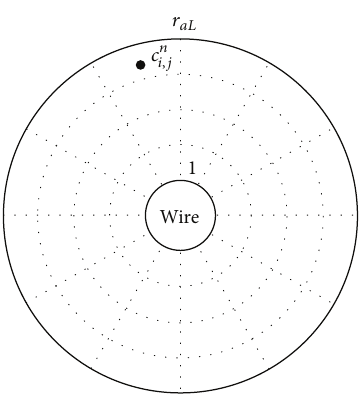
Figure 2: Simulation domain partitioning.